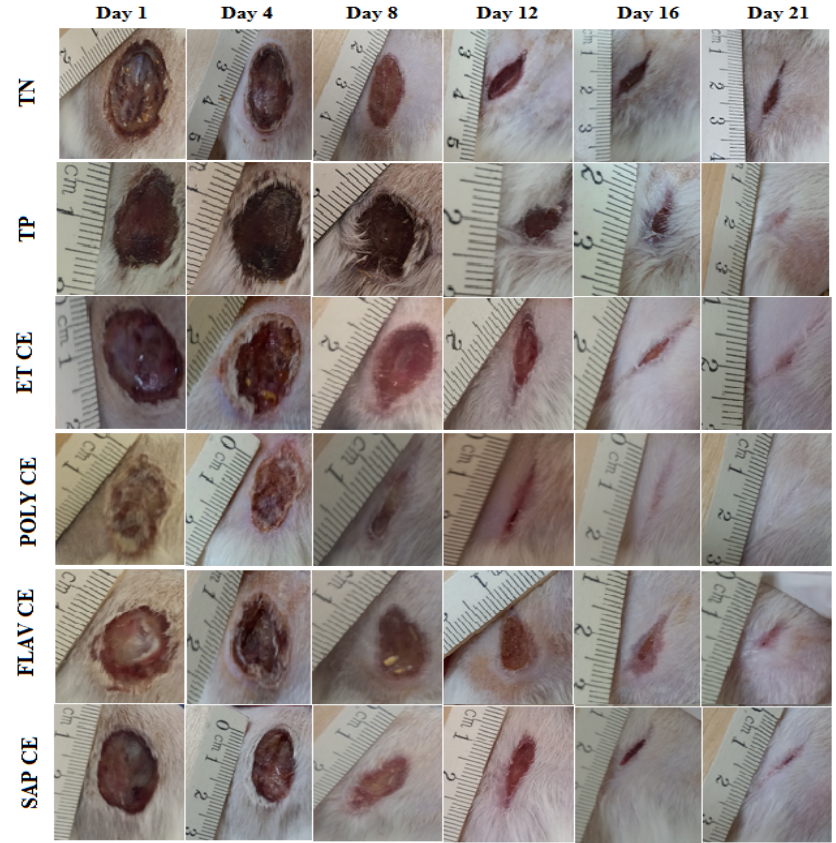
Figure 2. Macro-area of wounds in 1st, 4th, 8th, 12th, 16th and 21st day of experiment. CE, C. europaea , ET, Total extract; POLY, Polyphenols; FLAV, Flavonoids; SAP, Saponins; TP, Positive control; TN, Negative control.